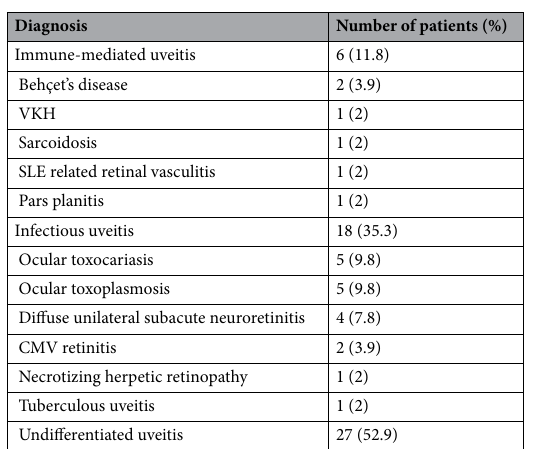
Table 2. Diagnoses of all 51 children with uveitis. CMV cytomegalovirus, SLE systemic lupus erythematosus, VKH Vogt–Koyanagi–Harada disease.